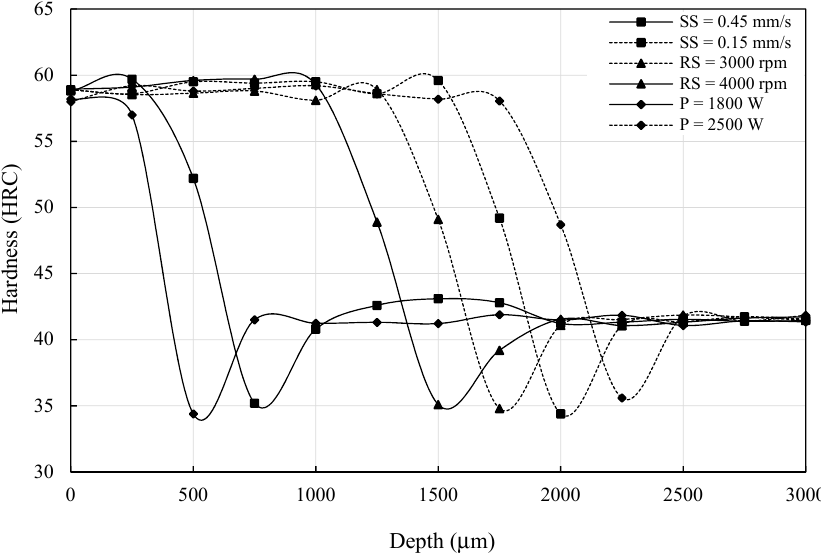
Figure 8. Typical hardness curves for gear teeth bottom versus process parameters.